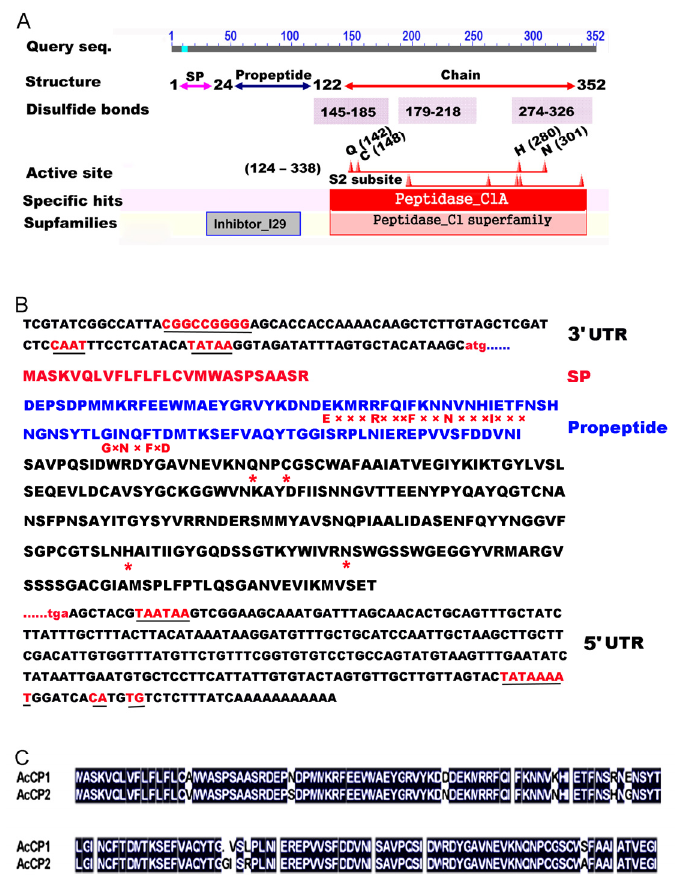
Figure 1. Representation of AcCP2 domains and deduced amino acid sequences. ( A ) Schematic demonstration of AcCP2 structure characteristics; ( B ) Deduced amino acid sequences of AcCP2. The letters underlined in nucleotide sequences indicate the CAAT box, TATA box and GC box in the upstream of start codon. CA-GU sequences are regarded as an alternative site combining PolyA synthase in higher plants. The consensus polyadenylation signal (AATAAA) is found in 3' UTR. SP, GxNxFxD and ERFNIN motifs are also noted in the propeptide. Conserved active sites (Gln, Cys, His and Asn) are labeled in asterisks (*); and ( C ) Alignment of amino acid sequences between AcCP1 (O23791) and AcCP2 (AEH26024)